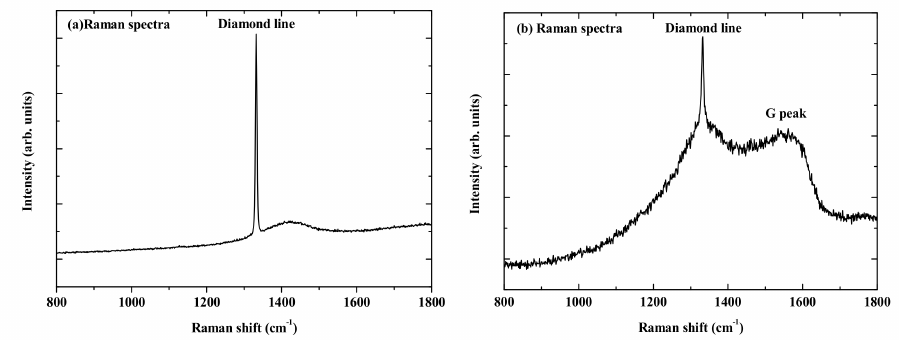
Figure 3. ( a ) Raman spectra obtained from area 1 (cid:13) in Figure 2b. ( b ) Raman spectra obtained from area 2 (cid:13) in Figure 2b.